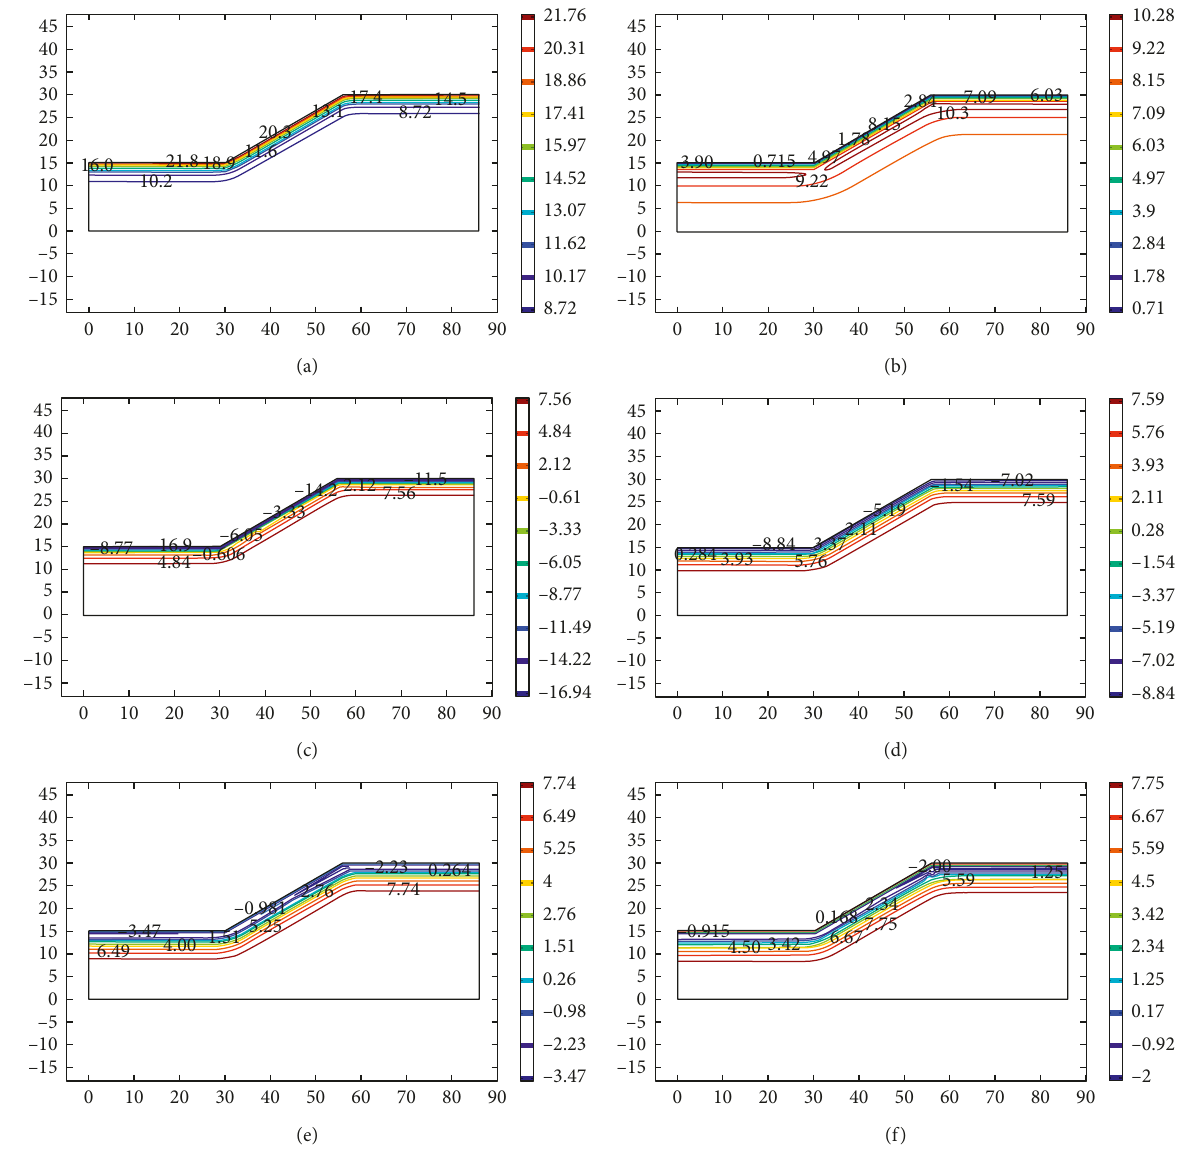
Figure 6: Distribution of slope temperature isoline at different times. (a) t 18.30 ° C; (d) t −